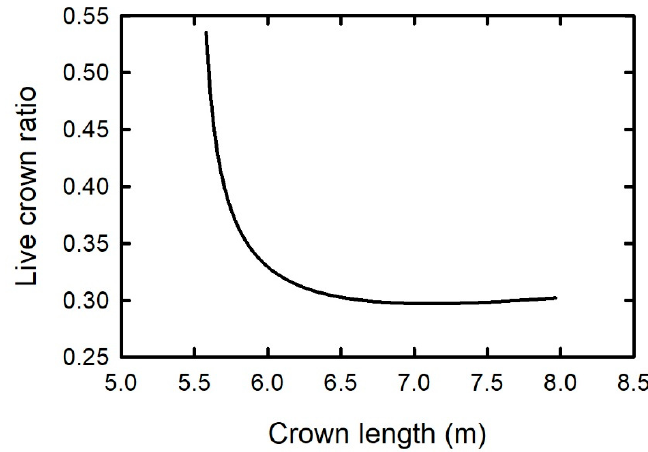
Figure 1. Hypothetical relationship between average live-crown ratio and average live-crown length for a loblolly pine plantation from 10 to 50-years old calculated with the biomechanical model of Dean et al. (2013). Initial planting density = 1200 trees/ha and site index = 18 m at base age = 25 years.